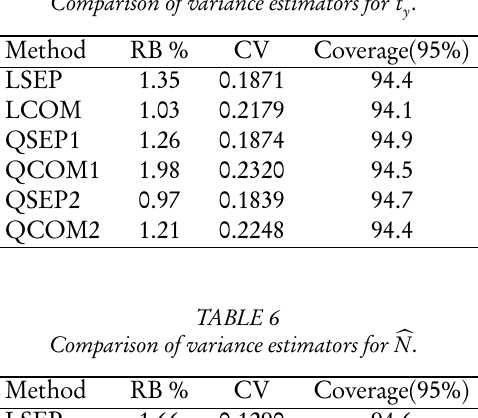
Comparison of variance estimators for t